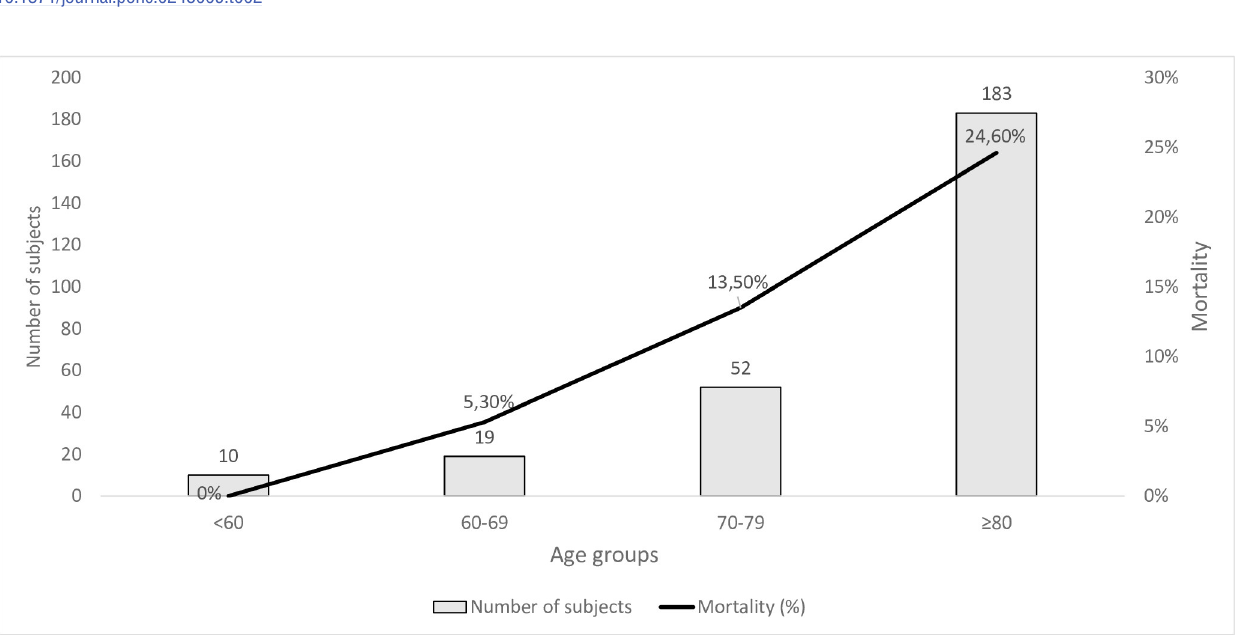
Fig 2. Distribution of 264 patients with SARS-CoV-2 infection according to age groups and mortality rates.